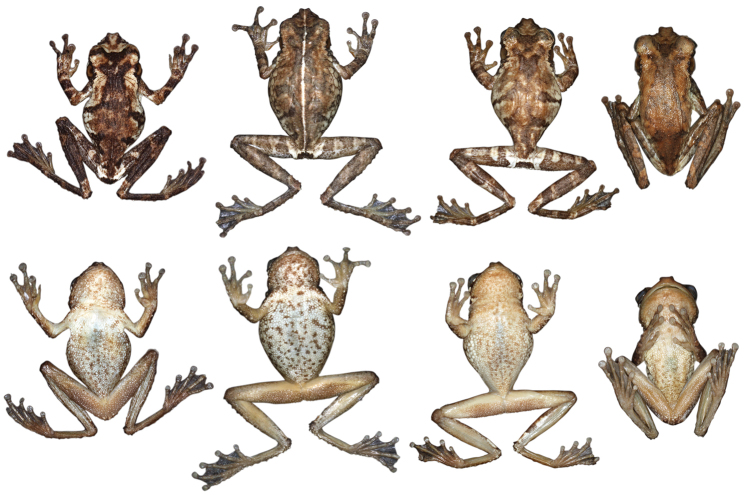
Adult male Osteocephalus vilmae showing variation in dorsal and ventral coloration of preserved specimens. Upper row, from left to right: CORBIDI 5031, CORBIDI 6469, CORBIDI 1086, CORBIDI 4773 (holotype), Peru, Región Loreto, Provincia Datem del Marañón, Jibarito, Capihuari Norte, Andoas, Pampa Hermosa.